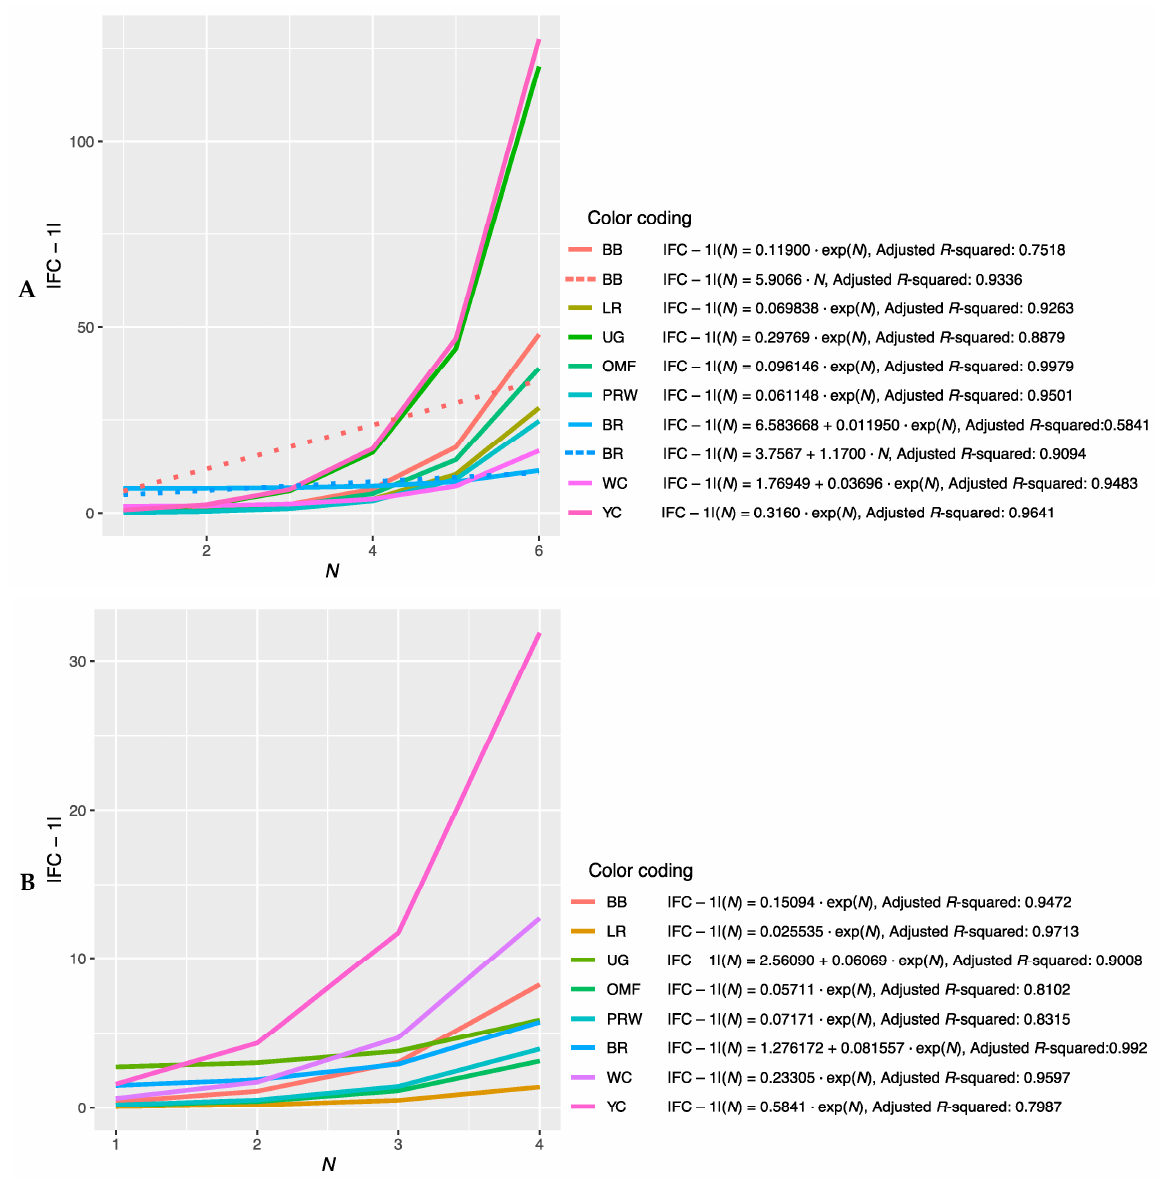
Figure 2. Combined plots for breed-specific regressions |FC − 1| = f ( N ) in the different breeds by muscle type. ( A ) Breast muscles; ( B ) thigh muscles.